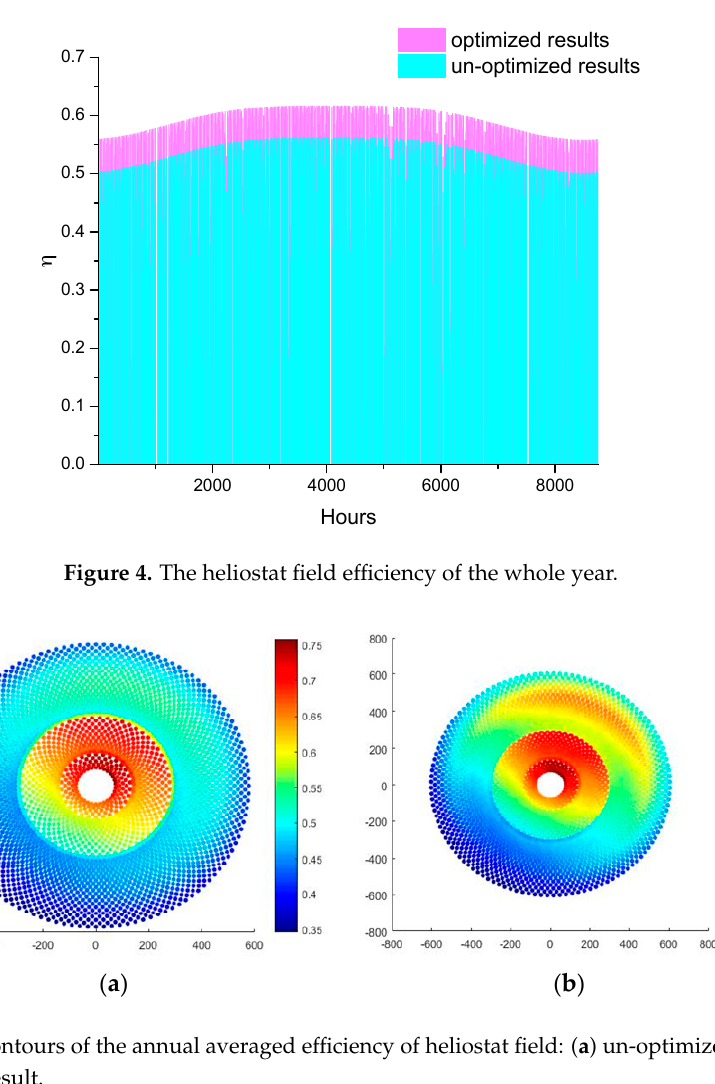
Figure 5. The contours of the annual averaged efficiency of heliostat field: ( a ) un-optimized result and ( b ) optimized result.